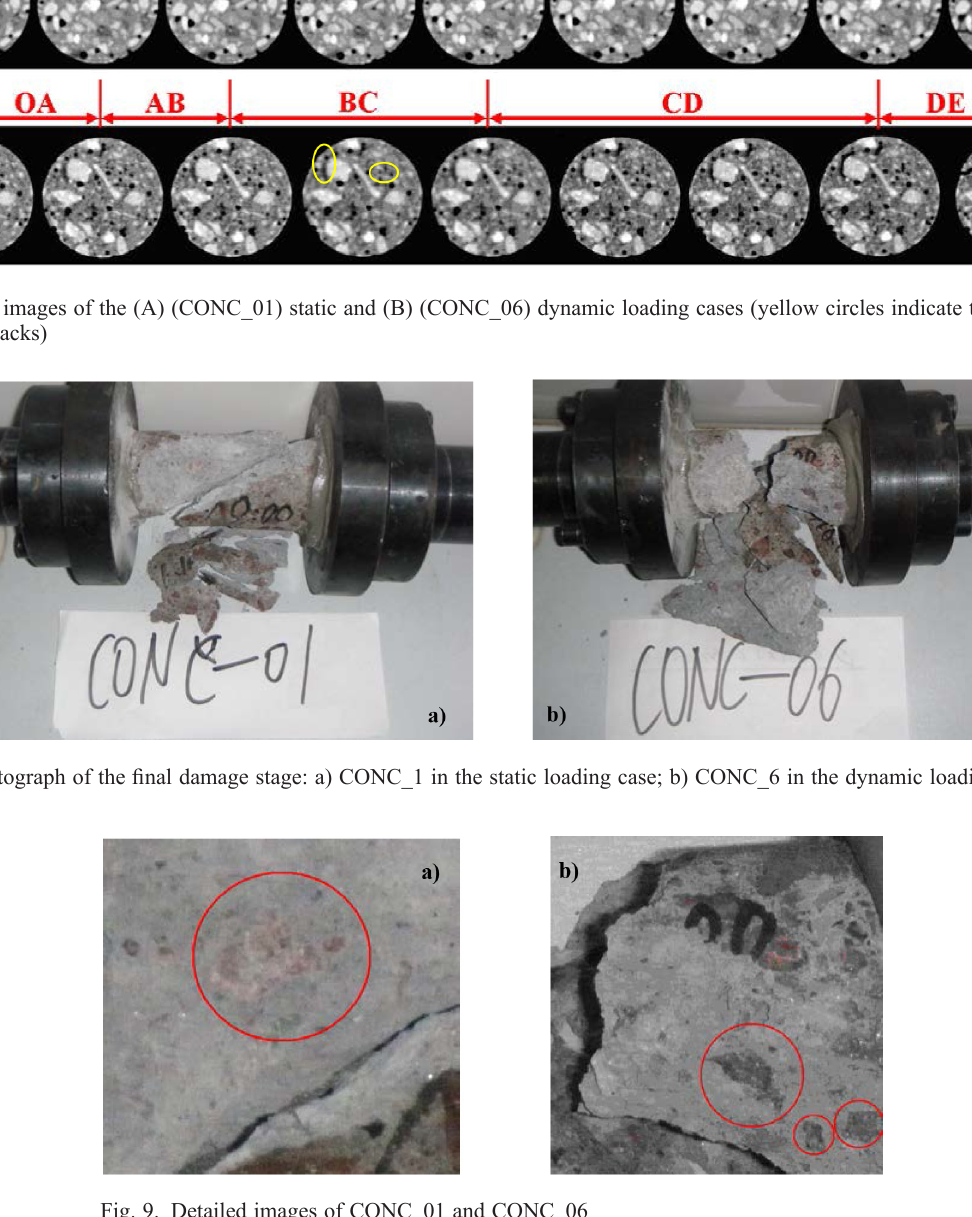
Fig. 9. Detailed images of CONC_01 and